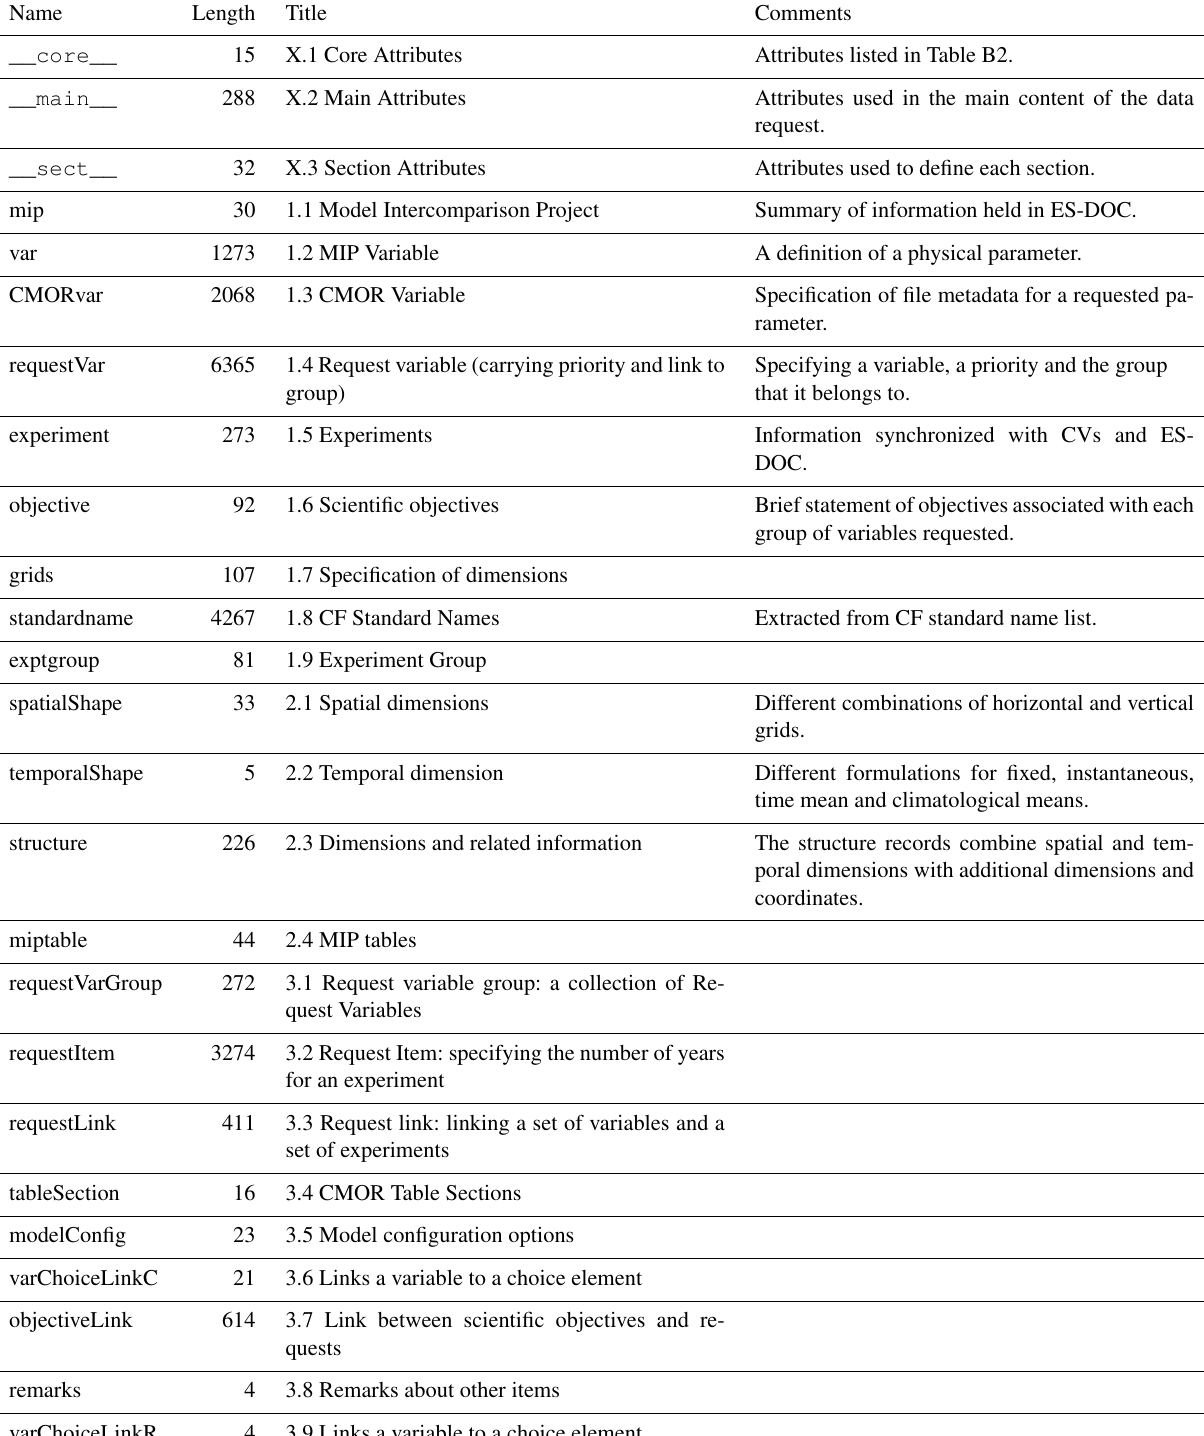
Table B3. DREQ sections: the DREQ database is split into the following sections, each taking the form of a database table with the number of records specified in column 2. The numbering in the “Title” column represents a provisional partitioning of records into